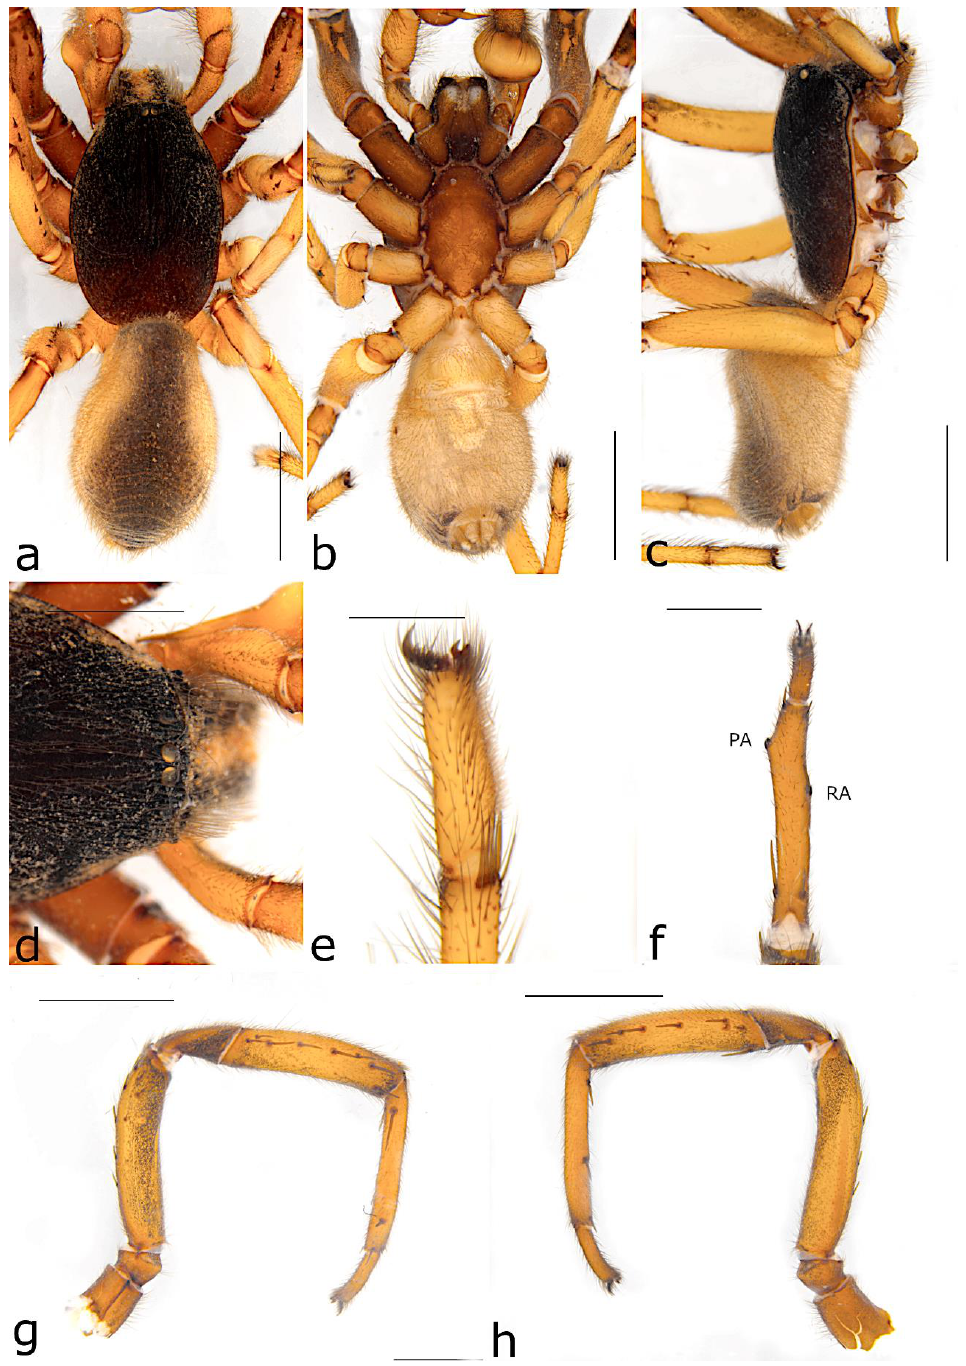
Figure 55. Ariadna subplana sp. nov. ♂ holotype (SAMA NN30479) from Stony Desert (SA): ( a ) habitus, dorsal view; ( b ) same, ventral view; ( c ) same, lateral view; ( d ) eyes, dorsal view; ( e ) left metatarsus IV, preening comb, retrolateral view; ( f ) left leg I, ventral view; ( g ) same, prolateral view; ( h ) same, retrolateral view. Scale bars ( a – c ) = 2 mm, ( d ) = 1 mm, ( e ) = 0.5 mm, ( f ) = 1 mm and ( g , h ) = 2 mm. Description. (based on holotype; SAMA NN30479). Total length ♂